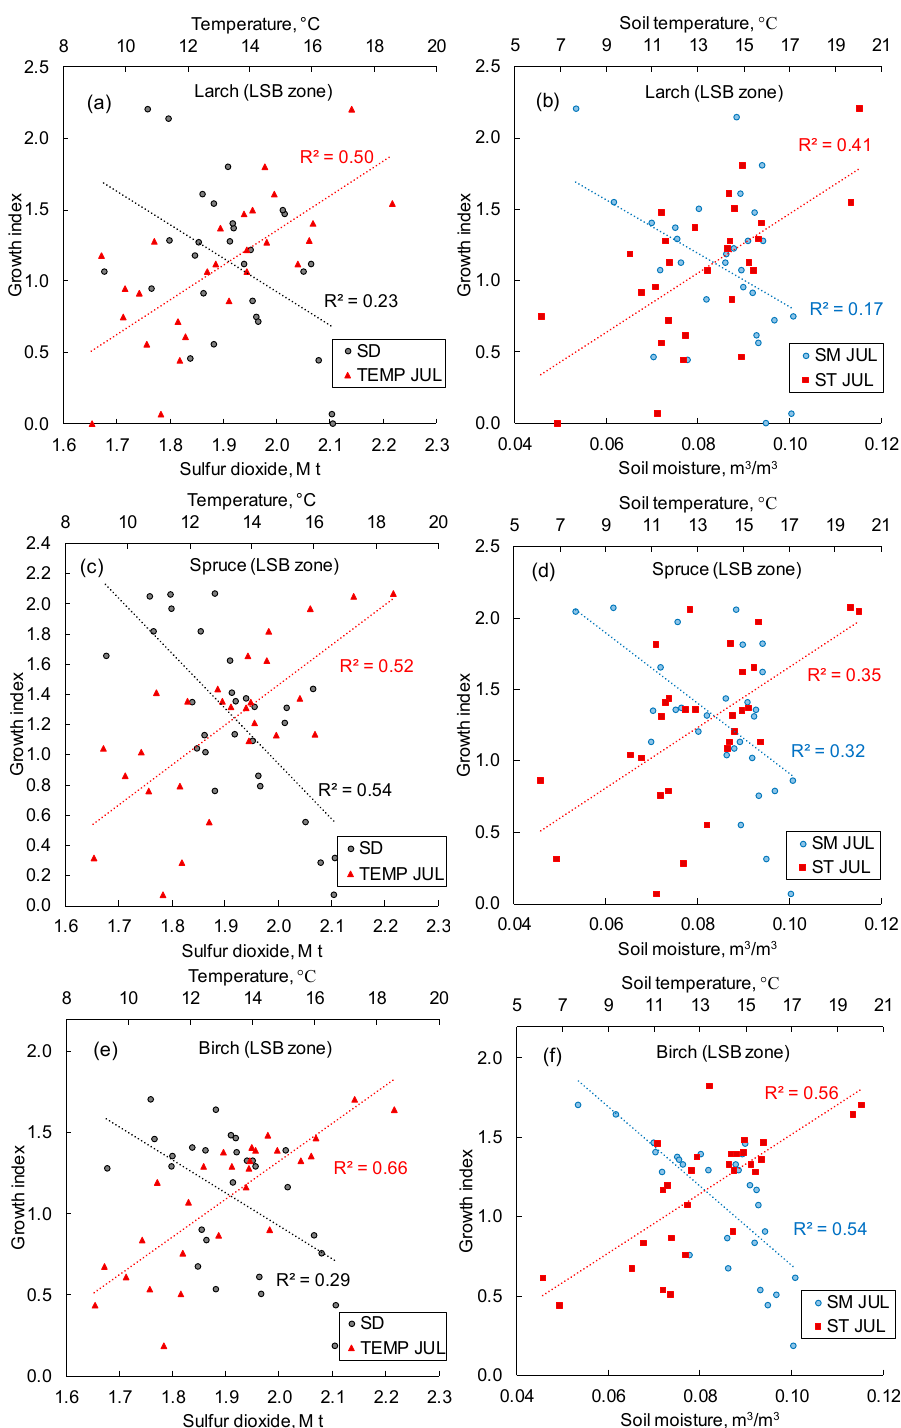
Figure 10. In the LSB zone, growth indexes of larch ( a , b ), spruce ( c , d ), and birch ( e , f ) increase with air and soil temperatures increase, and growth indexes decrease with sulfur dioxide emissions and soil moisture increases. TEMP and ST—air and soil temperatures, SM—soil moisture, SD—sulfur dioxide emission, JUL—July. The study period is 1993–2021. All trends are significant at p < 0.05. The growth index of willow shows a high response to the elevated temperatures (both soil and air) and a minor (non-significant) response to SO 2 (Figure 11a,b). There is a strong response of willow’s GI to the air temperature at the end (September) of the growth